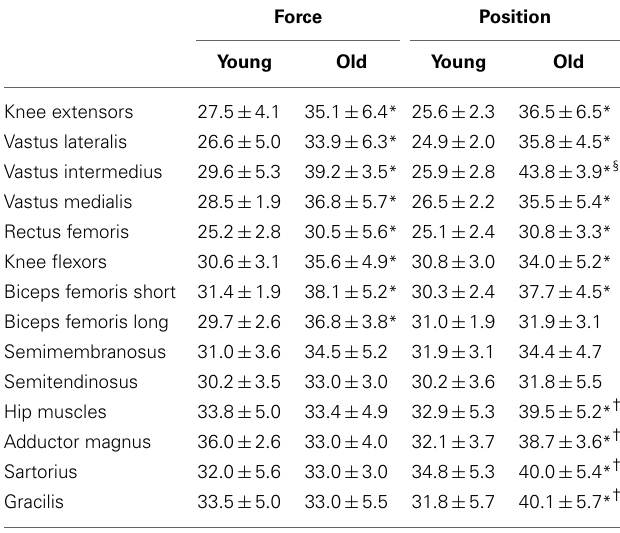
Table 1 | Muscle volumes (cm 3 ) of the left knee extensors. Table 2 | Glucose uptake heterogeneity (%) in lower limb muscles after fatiguing contractions that required either force or position